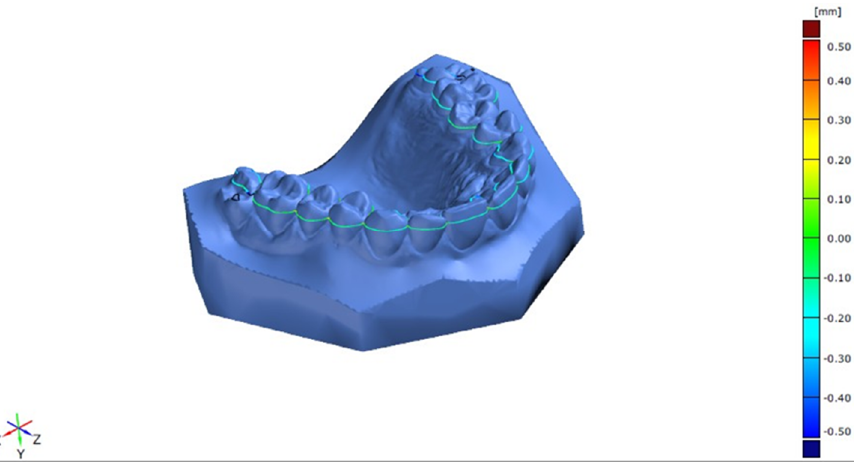
Figure 1. Digital model cross-section.